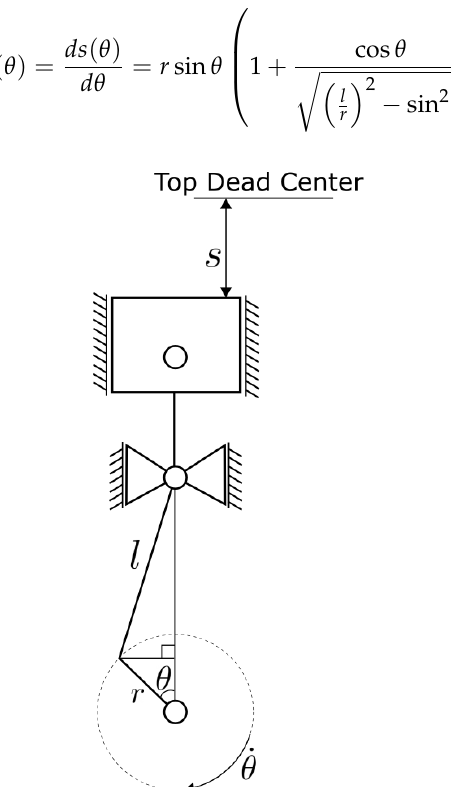
Figure 2. Crank-slider mechanism of large two-stroke